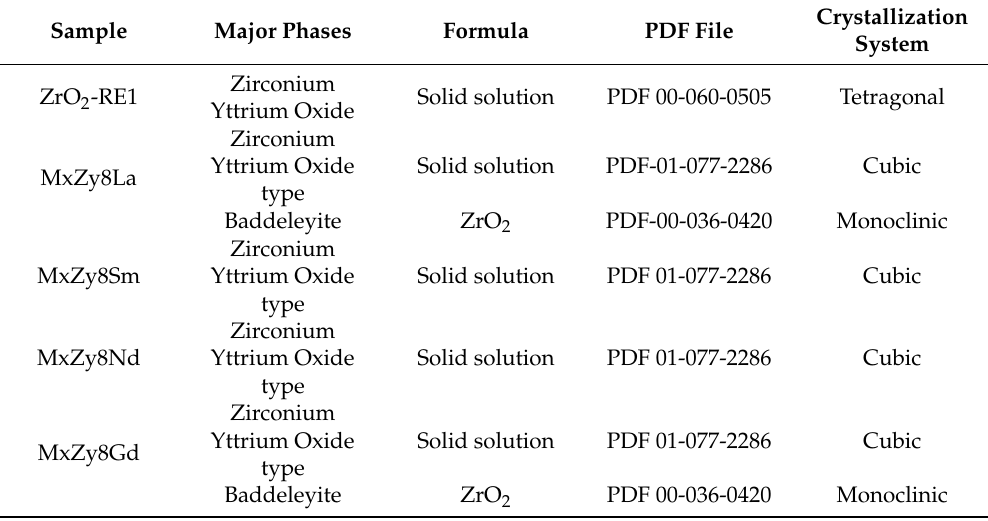
Figure 3. Diffraction spectrum for ZrO 2 -RE1, MxZy8La, MxZy8Sm, MxZy8Nd, and MxZy8Gd samples. Revised Table 8. Quantitative phase analysis of ZrO 2 doped